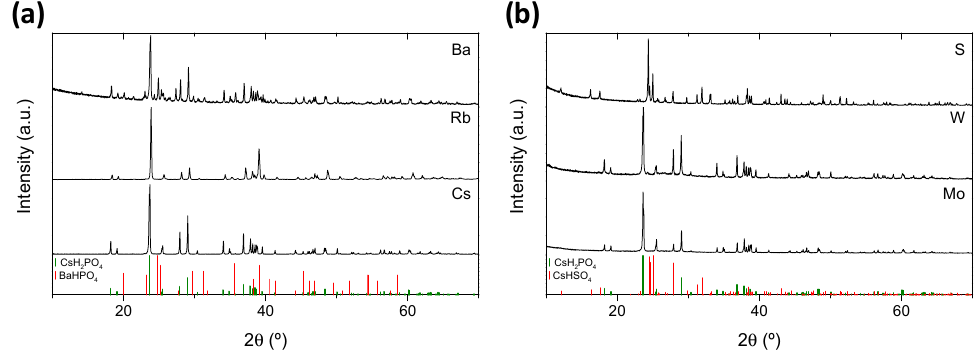
Figure 2. X-ray diffraction (XRD) patterns of (CsH 2 PO 4 ) 0.8 (A n H 3- n PO 4 ) 0.2 ( a ) and (CsH 2 PO 4 ) 0.8 (HBO 4 ) 0.2 ( b ) solid solutions.